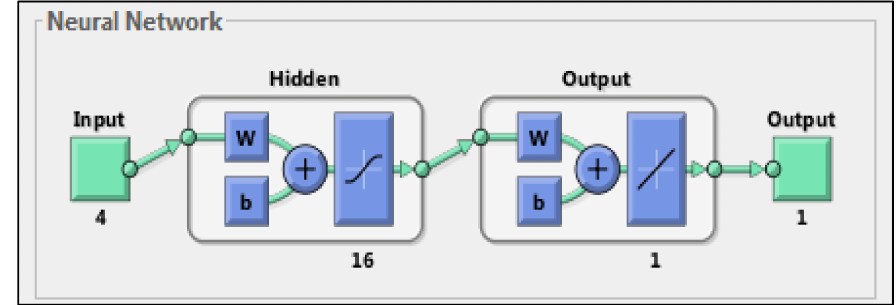
Figure 7. ANN configuration applied to normalized